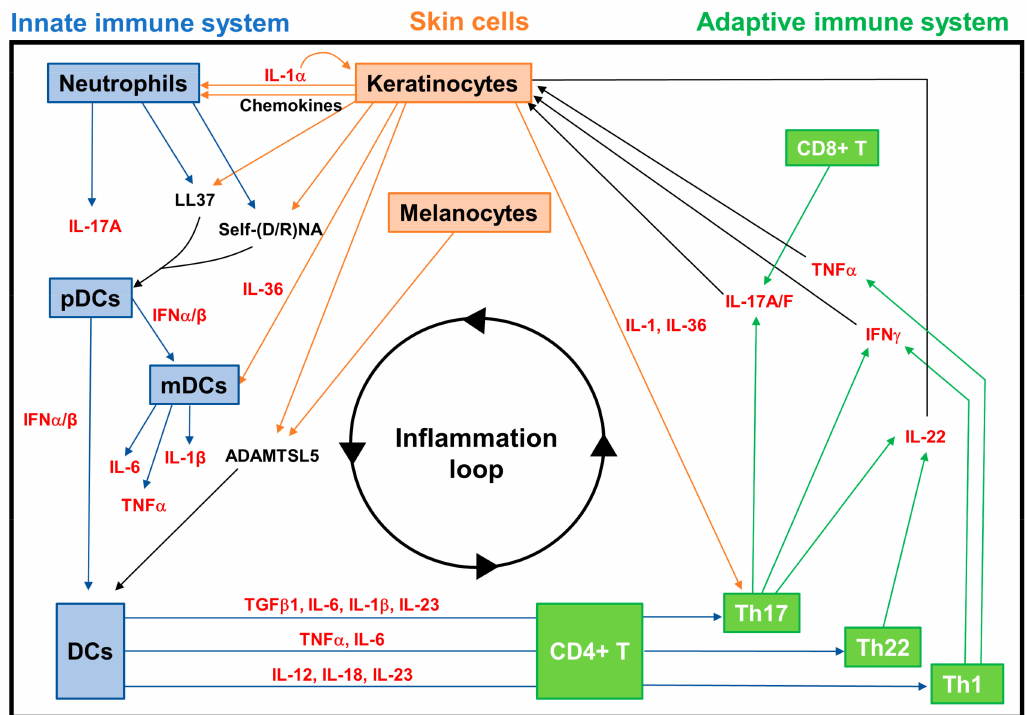
Figure 4. The inflammation loop at the core of psoriasis pathogenesis. The pathogenesis of psoriasis involves an interplay between innate immune cells (pDCs, mDCs, neutrophils, etc.), skin cells (keratinocytes, melanocytes, etc.) and adaptive immune cells (CD4 + and CD8 + T cells, Th1, Th17, Th22, Treg, etc.). The crosstalk between these cells is mediated by molecules such as antimicrobial peptides LL37 and ADAMTSL5, produced by keratinocytes and / or melanocytes, which act like autoantigens. Additionally, several cytokines, shown in red, and chemokines are fundamental in the process. DCs, dendritic cells; pDCs, plasmacytoid dendritic cells; mDCs, myeloid dendritic cells; IL, interleukin; TNF, tumor necrosis factor; IFN, interferon; TGF, transforming growth